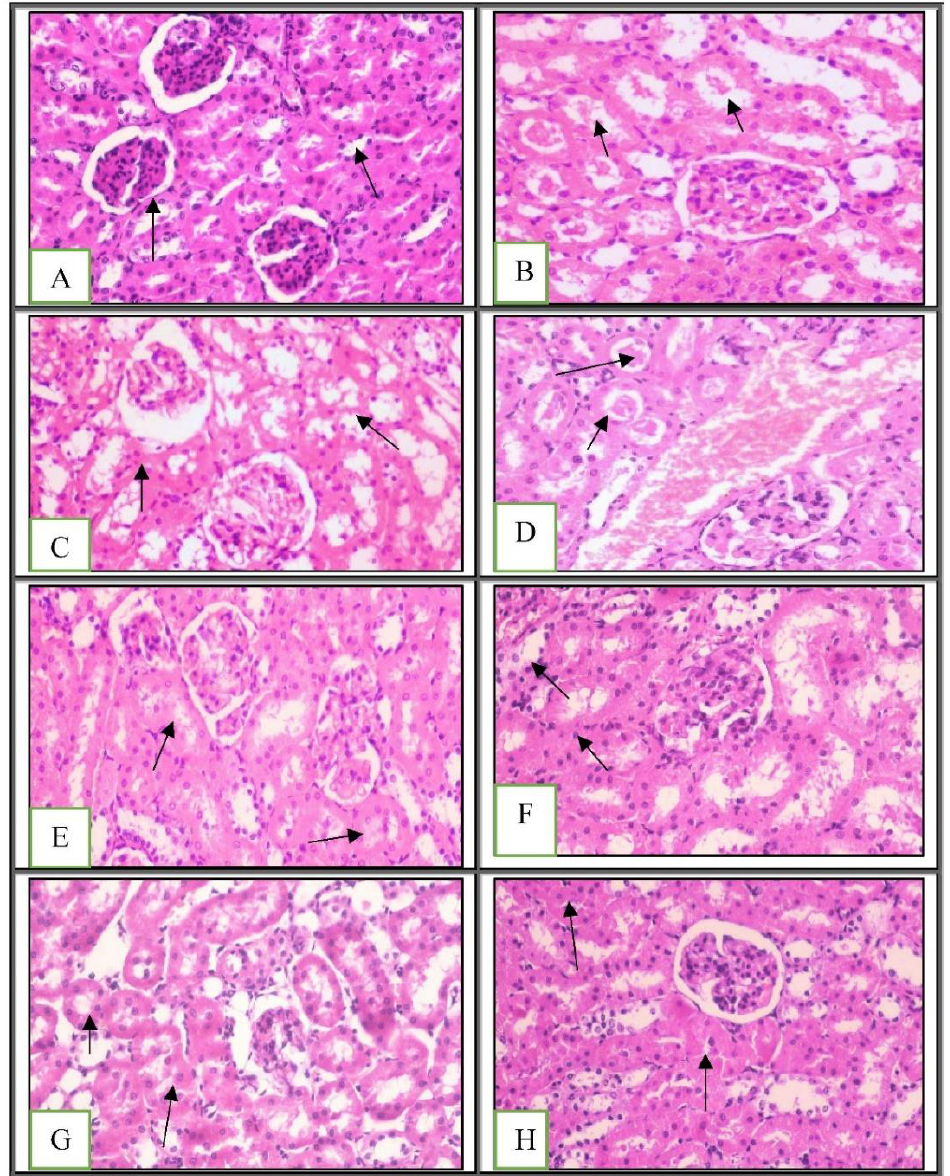
Figure 4. Histopathological examination of kidney tissues: ( A ) showing normal histological structure of kidney parenchyma arrow score ( 0 ) (H&E × 400); ( B–D ) showing tubular epithelial cell degeneration with intraluminal albuminous material arrow score ( 2 ) (H&E × 400); ( E – H ) showing tubular epithelial cell degeneration and narrowing of tubular lumen arrow score ( 1 ) (H&E × 400). ( A ) Negative control; ( B ) positive control; ( C , D ) green tea; ( E ) chia seed; ( F ) chitosan; ( G ) probiotic; ( H ) mixture. A 50 µM bar scale was used for all the tissues. Table 2. Grading of the renal scoring.